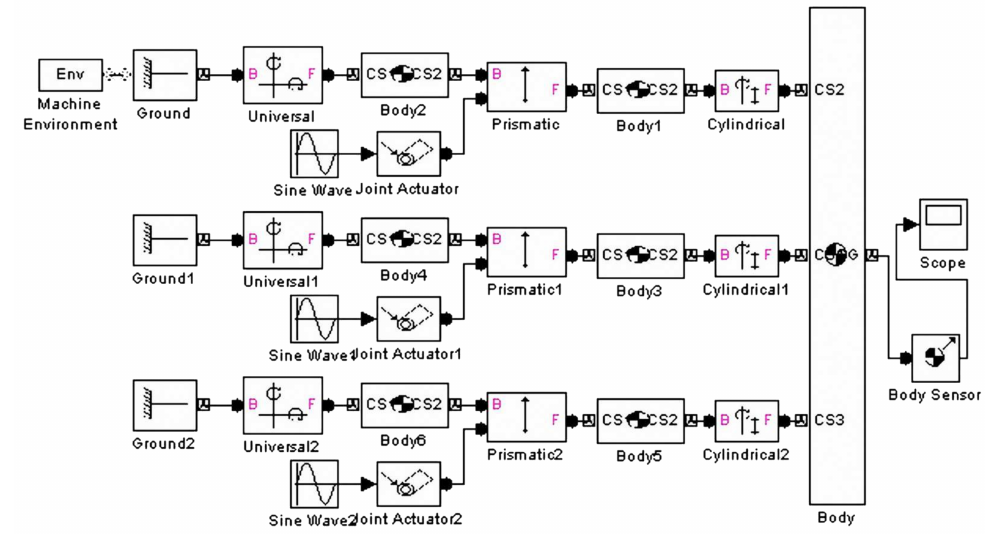
Figure 5. Structure of the 3-UPC type parallel prototype manipulator using SimMechanical @ software.